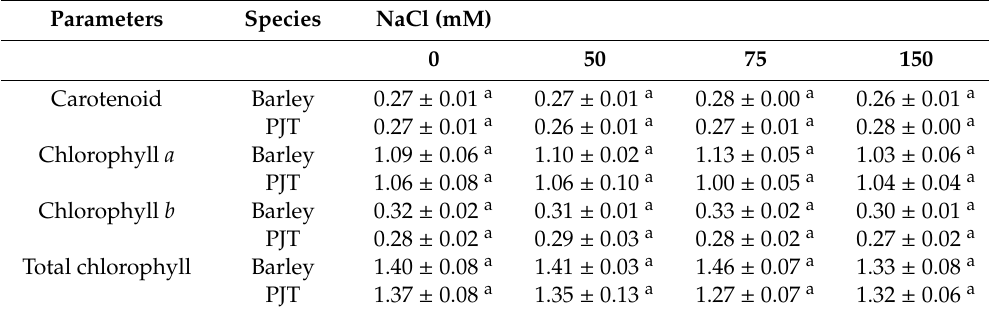
Table 1. The e ff ect of increasing salinity on carotenoid, chlorophyll a , and chlorophyll b concentrations (mg g − 1 fresh weight) in barley and Peucedanum japonicum (PJT).